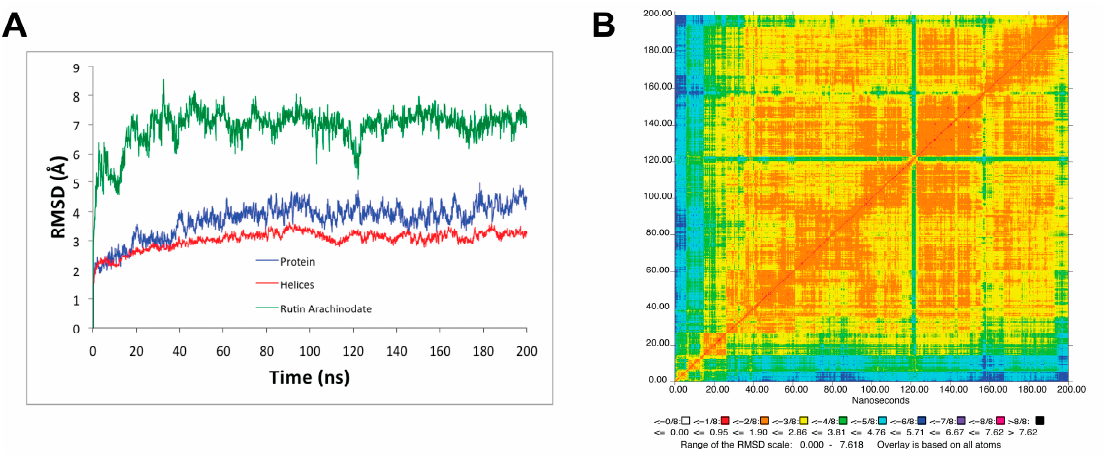
Figure 3. Stability of the MD simulation. ( A ) Root–mean–square deviation (RMSD) for all backbone protein, transmembrane helices, and rutin arachidonate with respect to the minimized initial structure; ( B ) 2D-RMSD for rutin arachidonate. Figure was rendered using the Simulaid program [53].